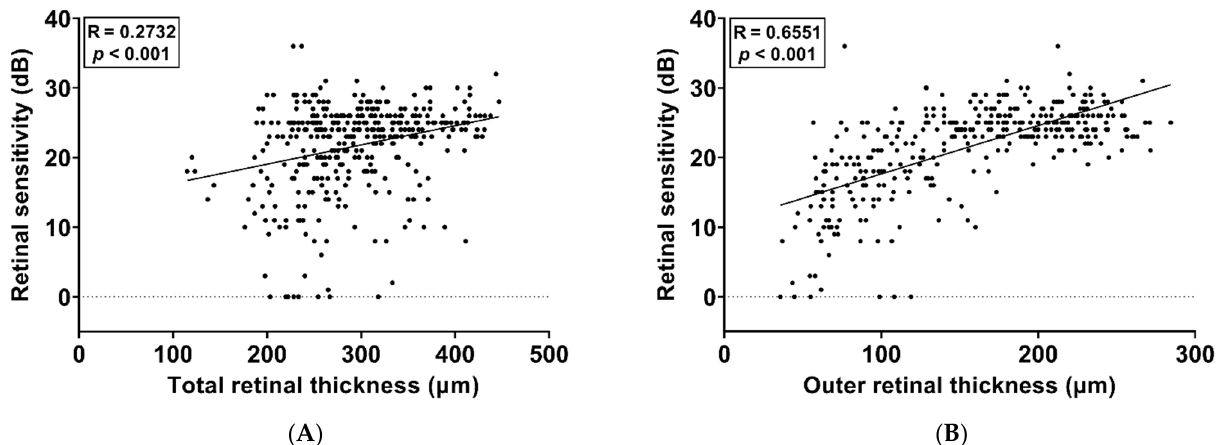
Figure 5. Scatterplots with linear regression analysis show the correlation of the mean retinal sensitivity with the total retinal thickness ( A ) and outer retinal thickness ( B) .